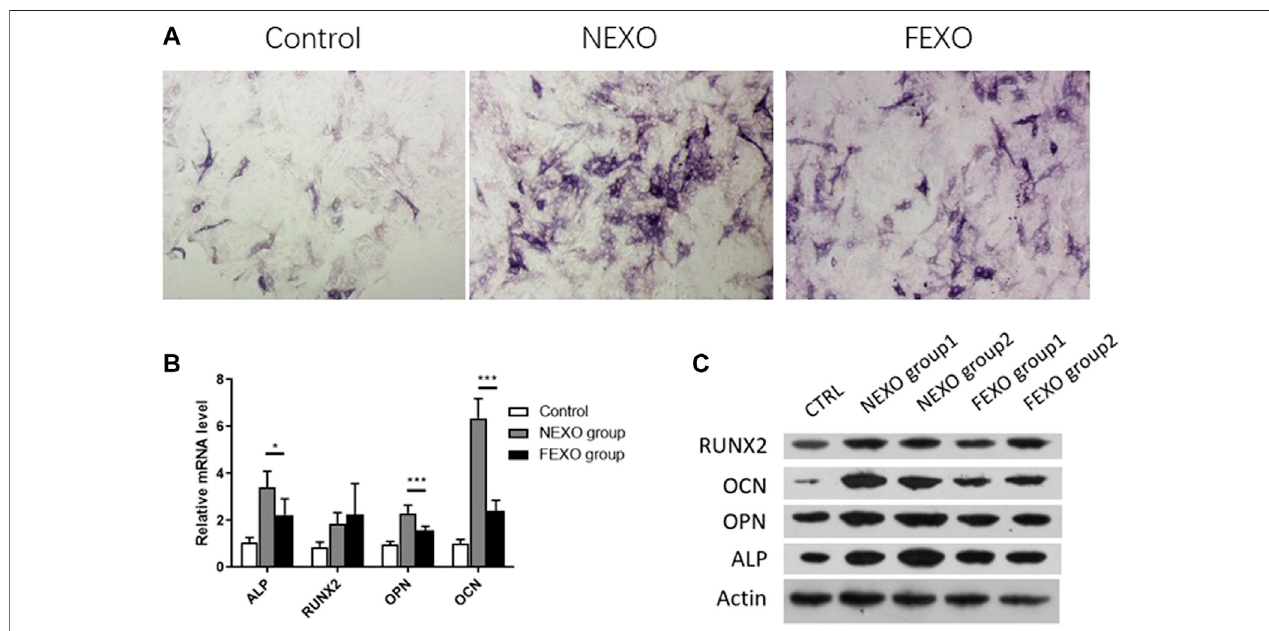
FIGURE 2 | Veri fi cation of the effect of exosomes on osteogenic differentiation. (A) ALP staining for MC3T3-E1 cells treated with NEXO and FEXO, individually. (B,C) qPCR and WB analysis of osteogenesis-related gene expressions in MC3T3-E1 cells. All results are presented with three replicates. * p ≤ 0.05, *** p ≤